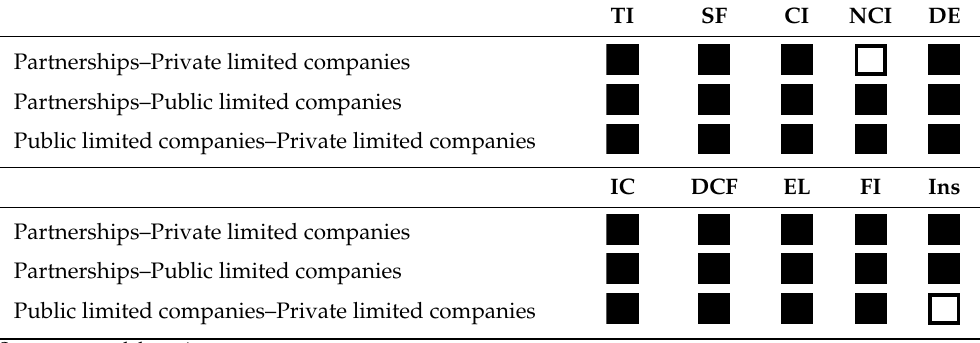
Table 7. The output of the pairwise comparison of the legal form.